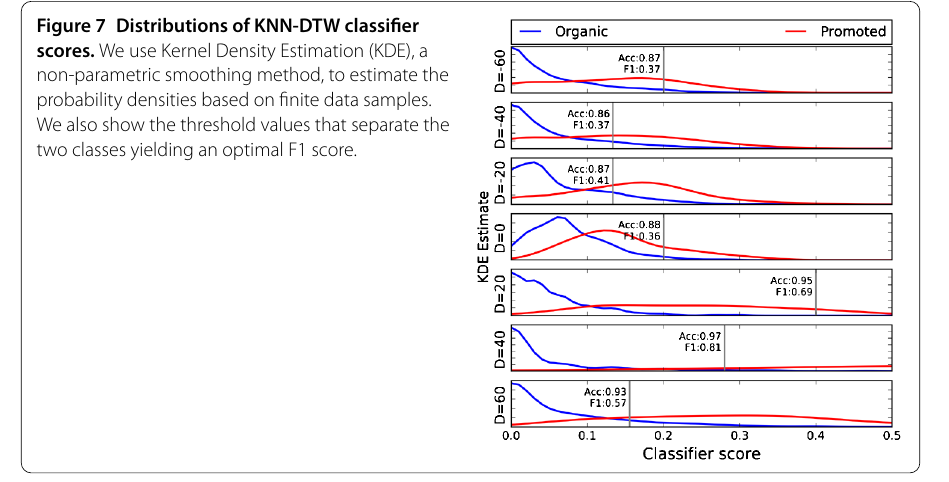
Figure 7 Distributions of KNN-DTW classifier scores. We use Kernel Density Estimation (KDE), a non-parametric smoothing method, to estimate the probability densities based on finite data samples. We also show the threshold values that separate the two classes yielding an optimal F1